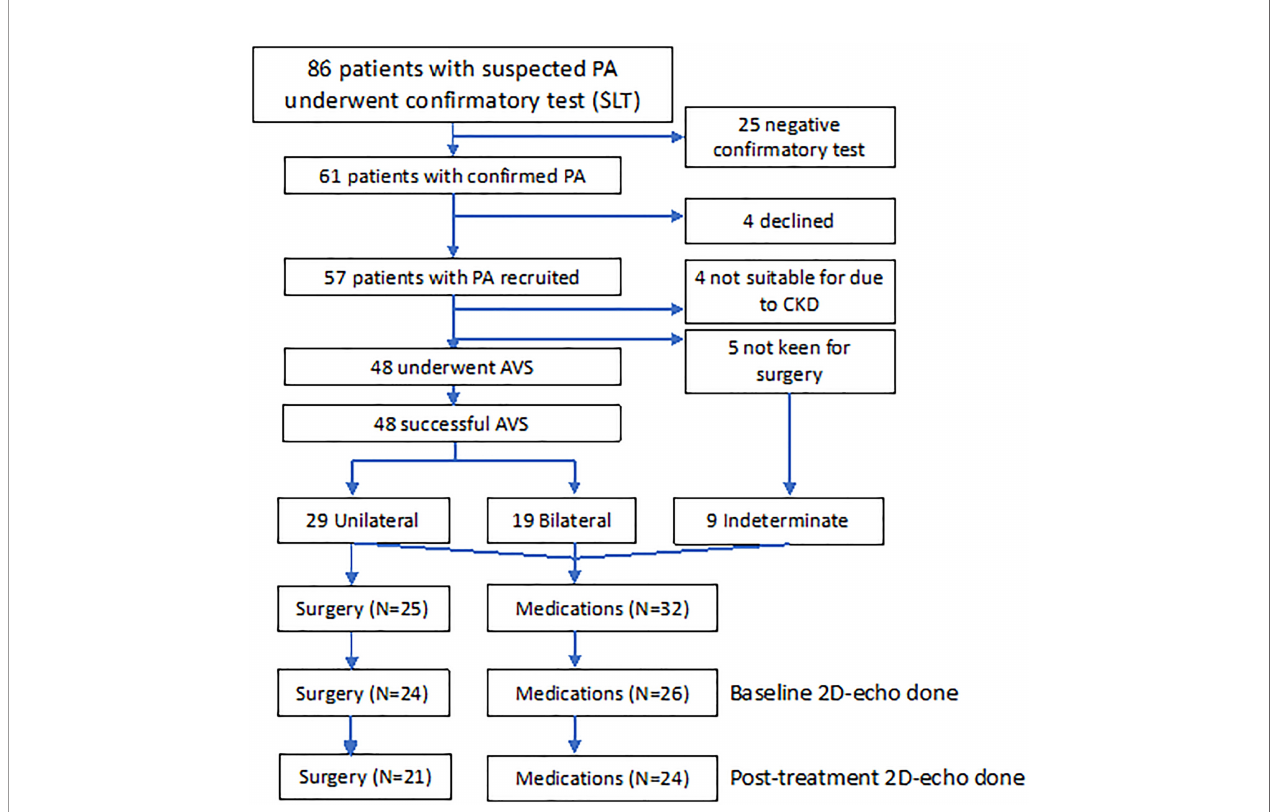
FIGURE 1 | Consort diagram of 57 patients with PA recruited into study treated with adrenalectomy (n = 25) and medications (n = 32). AVS, adrenal vein sampling; CKD, chronic kidney disease; SLT, saline-loading